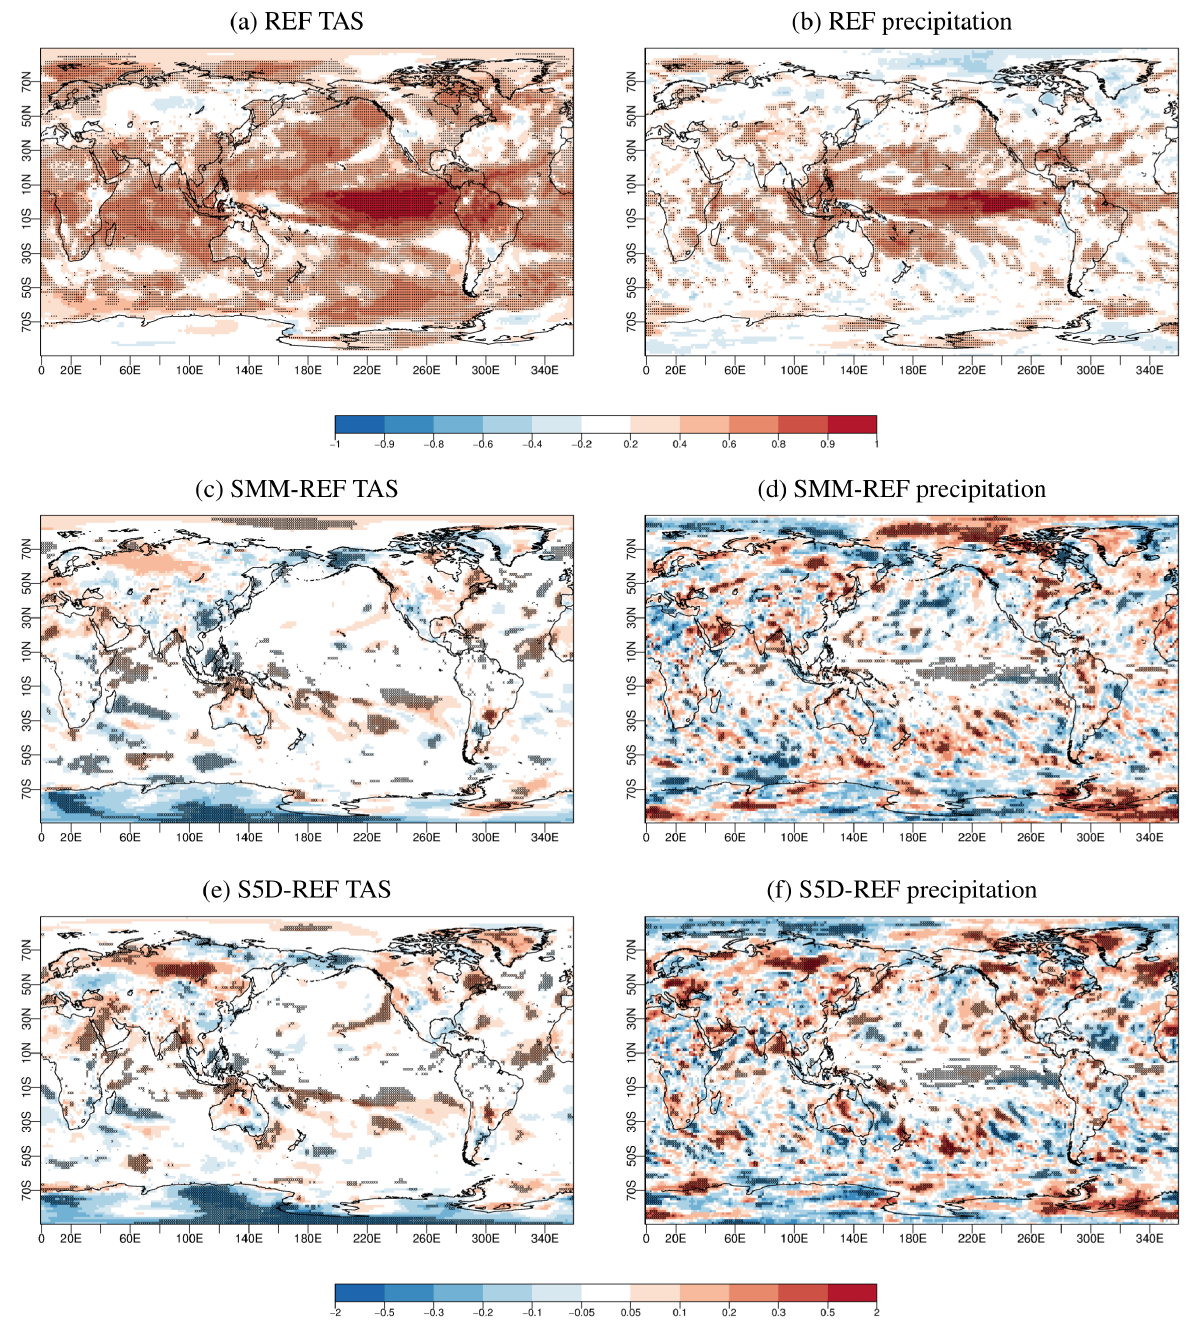
Figure 9. REF experiment DJF correlation (top row) for near-surface air temperature (left) and precipitation (right) with respect to ERA- Interim and GPCP, respectively. Areas with correlation significant at a 95% level are marked by dots. Second (or bottom) row: difference in correlation between experiments SMM (or S5D) and REF. The significance of correlation differences (hatched areas) is assessed following Zou